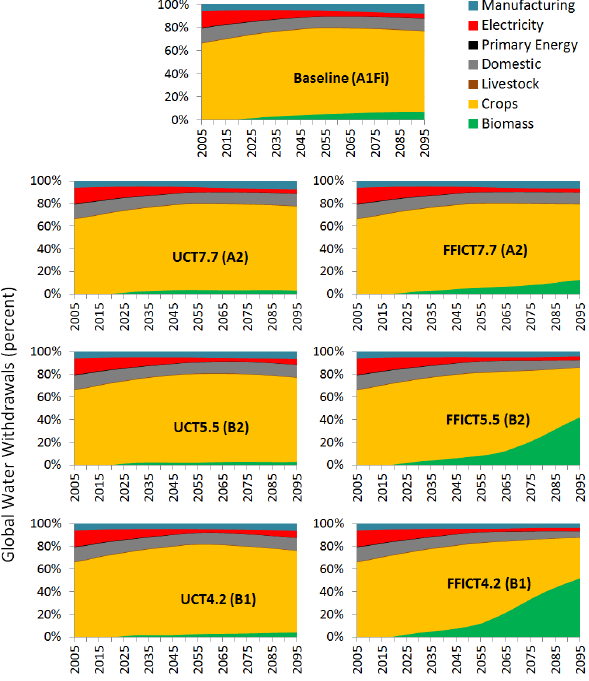
Figure 10: GCAM’s distribution of global water demands (withdrawals) by demand sector for the baseline scenario (no climate policy) and the six climate change mitigation policy scenarios